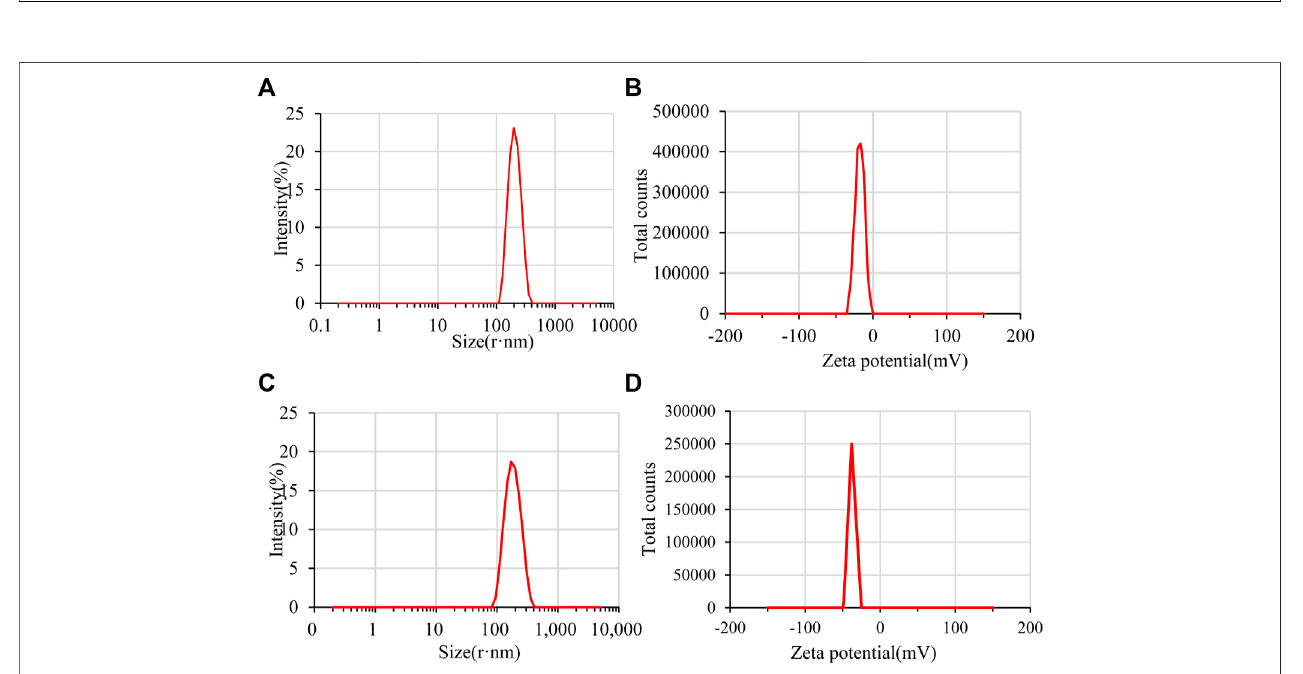
FIGURE 4 | Particle size and zeta potential of ZH-LUT (A,B) and GZH-LUT (C,D) .